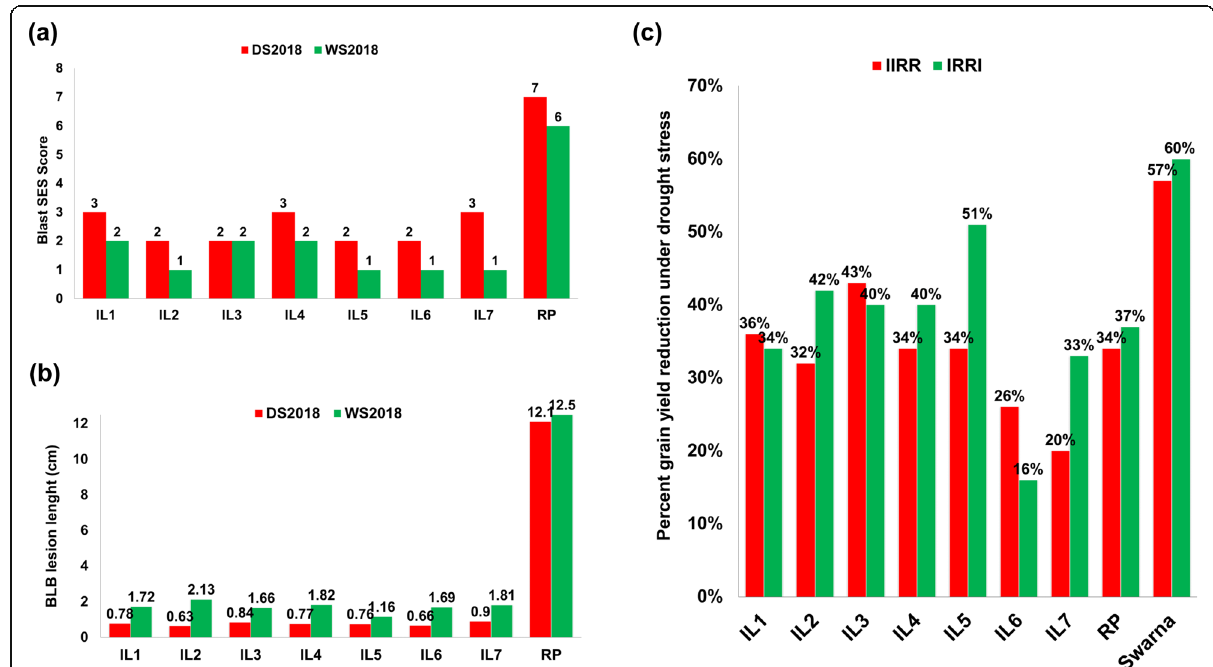
Fig. 2 Evaluation of ILs for blast, BLB and drought tolerance Evaluation of promising ILs for the targeted traits during DS2018 and WS2018 (a) performance of ILs and recurrent parent under UBN (uniform blast nursery), (b) performance of ILs for BB resistance by clip inoculation method, (c) performance of ILs for grain yield under reproductive stage drought condition at two locations (IRRI Hyderabad and IIRR Rajendranagar). Performance of ILs was found superior for the targeted traits (blast, BB and drought) in comparison to recurrent parent (RP, Swarna+drought)